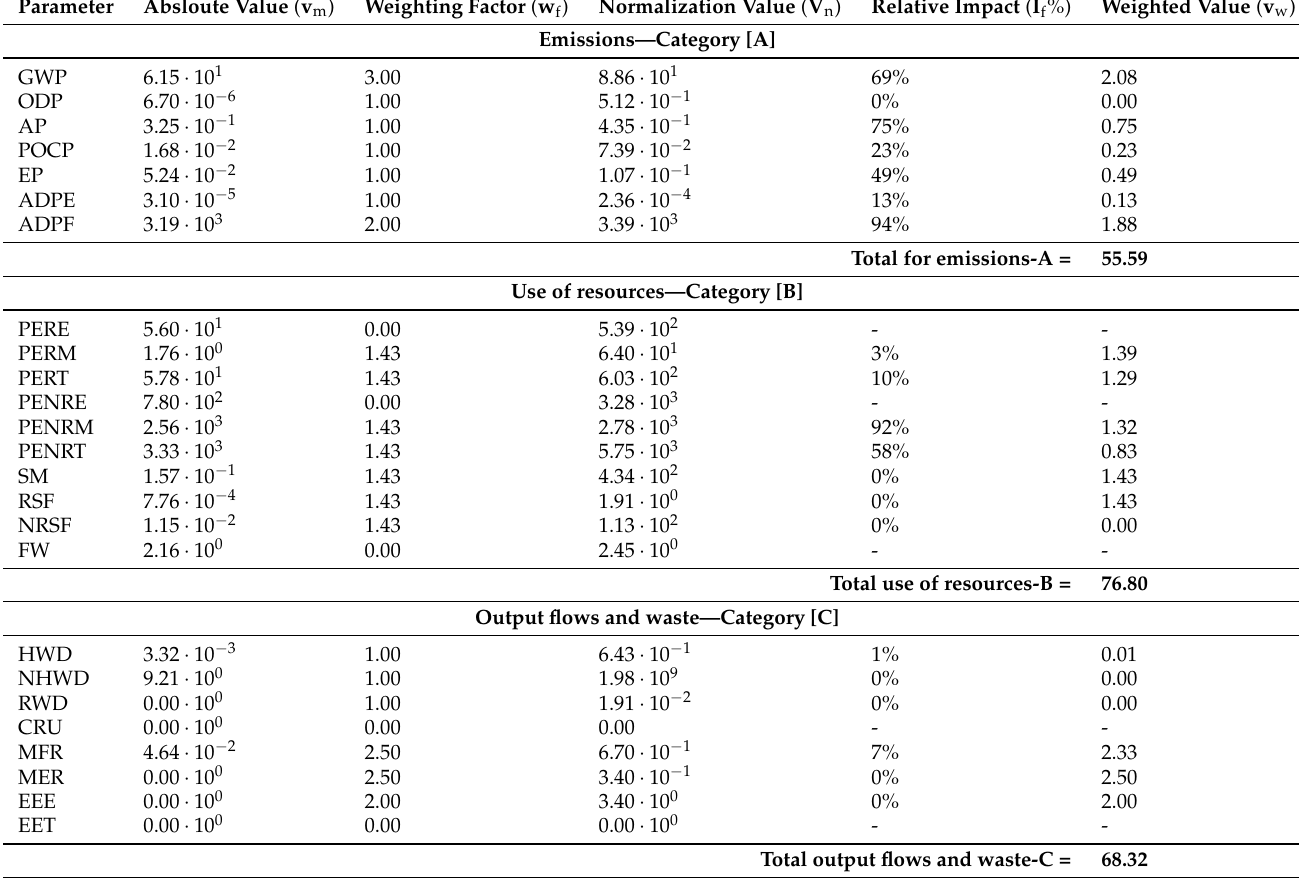
Table 8. Example of evaluated EAR index for the different impact categories related to the wearing mixture from the Norwegian market (Norge wearing, ref. third column of Table 6). The relative impact is reported as a percentage